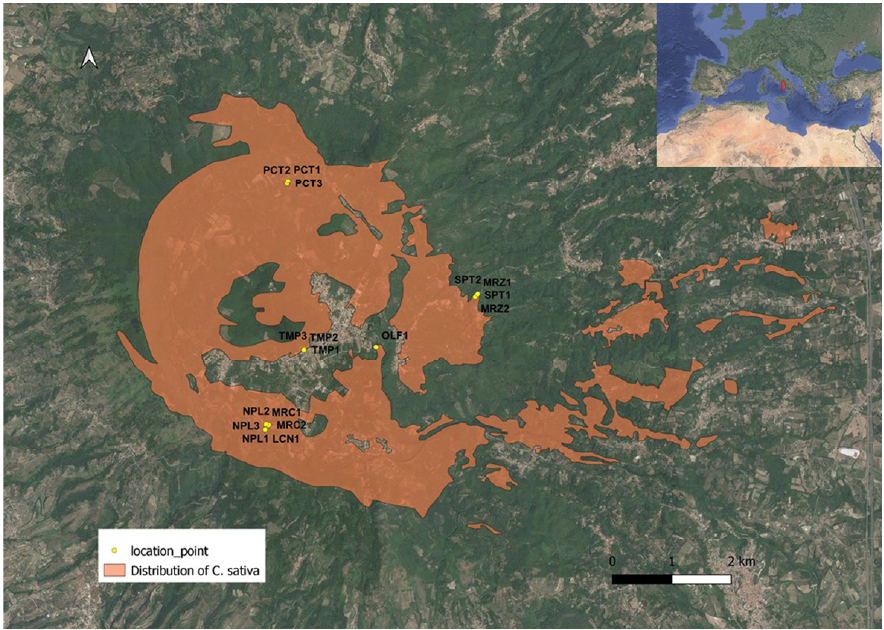
Figure 1. Location of sampling points of C. sativa and distribution of chestnut trees in the study area within the Regional Park “Volcanic Area of Roccamonfina and Foce Garigliano”, Campania (Italy). The genetic diversity values were pairwise calculated for the 17 chestnut samples and then elaborated by PCoA for RAPD and KASP markers, respectively. Both PCoA evidenced the genetic distribution of the analyzed genotypes on the first two axes, explaining the 79% of the variability detected by RAPD markers (Figure 2A) and the 70% of the variability detected by KASP markers (Figure